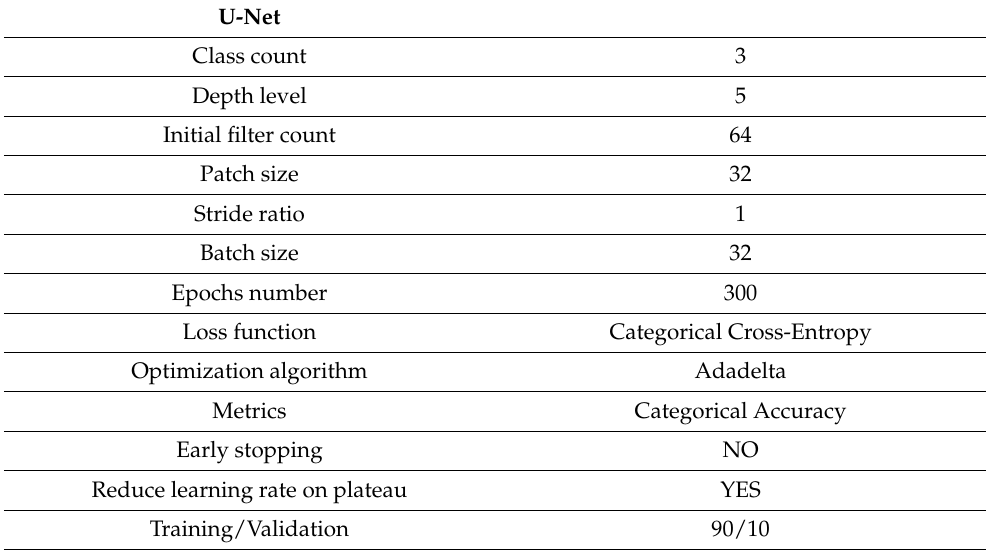
Table 2. Training parameters chosen after several tests and set before starting the